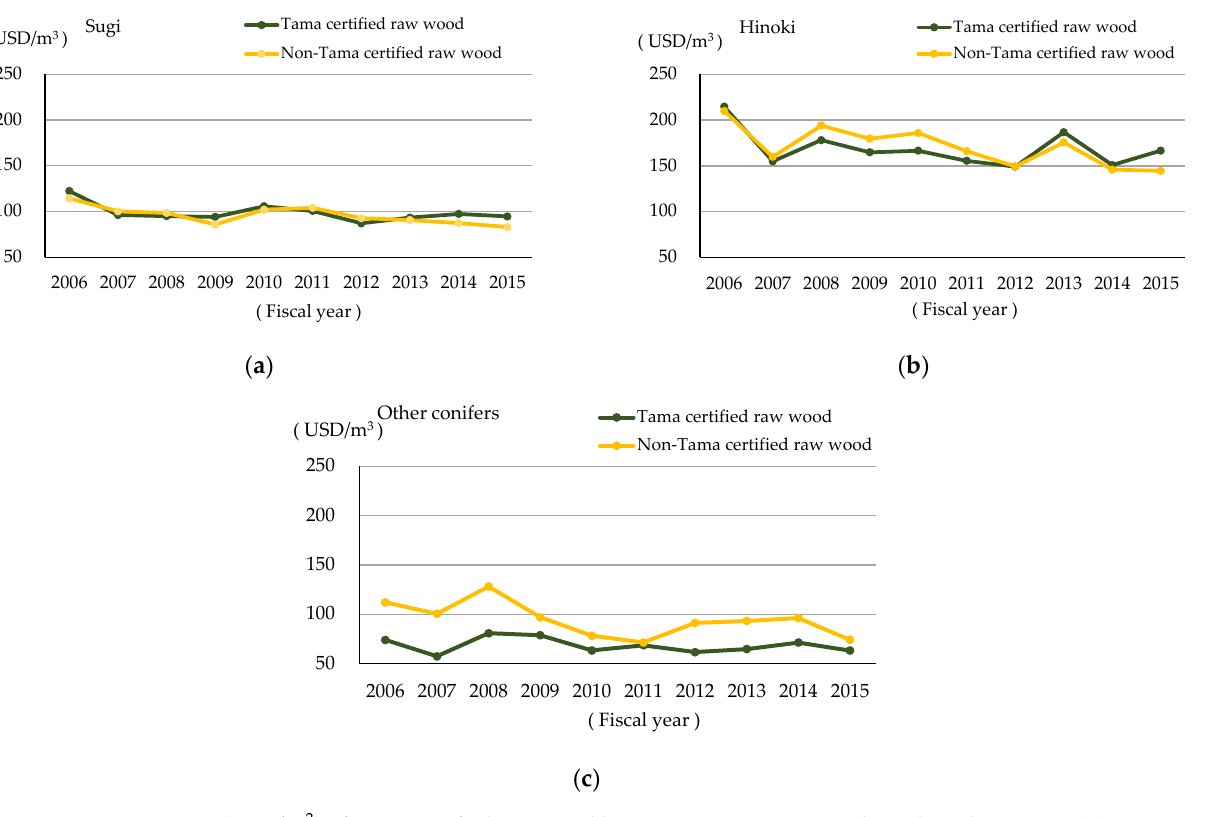
Figure 7. Average price (USD/m 3 ) of Tama-certified raw wood by tree type at Tama Roundwood Market Center: ( a ) average price of sugi; ( b ) average price of hinoki; ( c ) average price of other conifers.